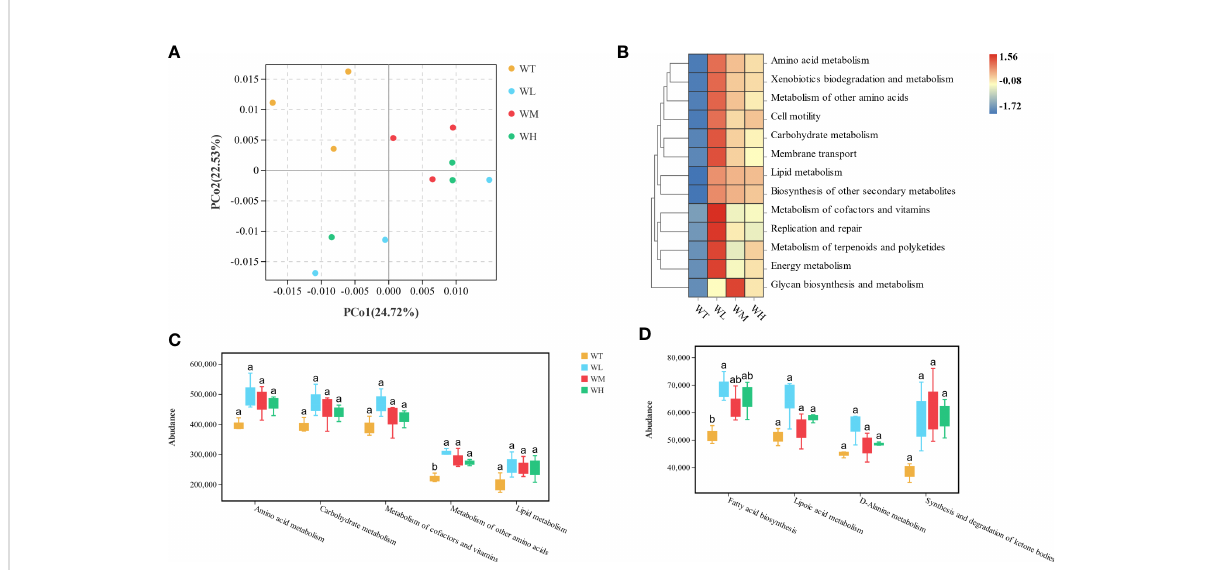
FIGURE 3 (A) Principal coordinate analysis (PCoA) plot based on weighted UniFrac distances. (B) Heatmap of the predicted microbial function at level 2 using PICRUSt2. (C) Box plot of the water microbiota predicted to function at level 2 (one-way ANOVA followed by Turkey ’ s honestly signi fi cant difference (HSD) post-hoc analysis). Boxes with different superscript letters are signi fi cantly different ( p < 0.05). (D) Box plot of the water microbiota predicted to function at level 3 (as